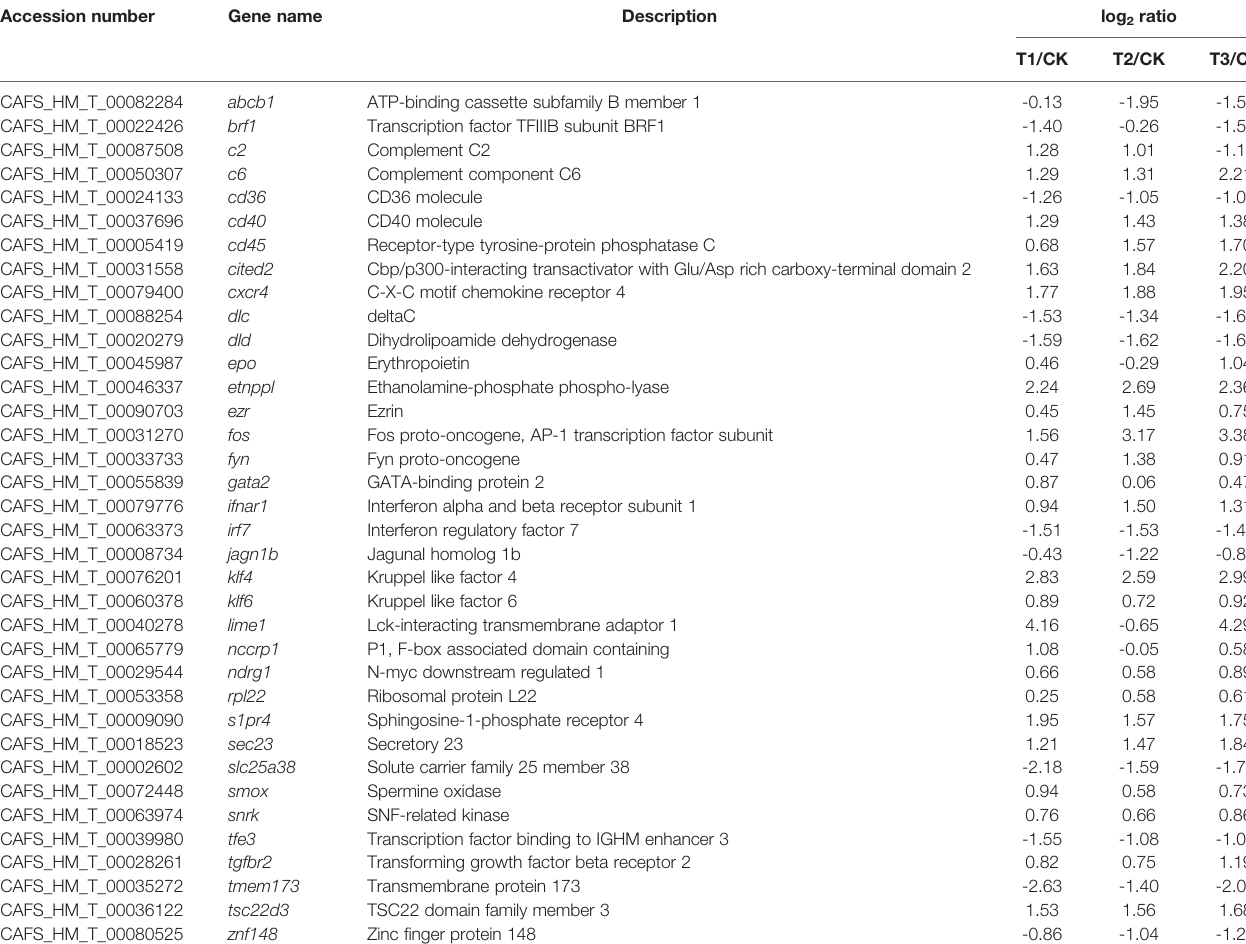
TABLE 3 | The representative immunity-related DEGs in the gills of H. molitrix in varying degrees of